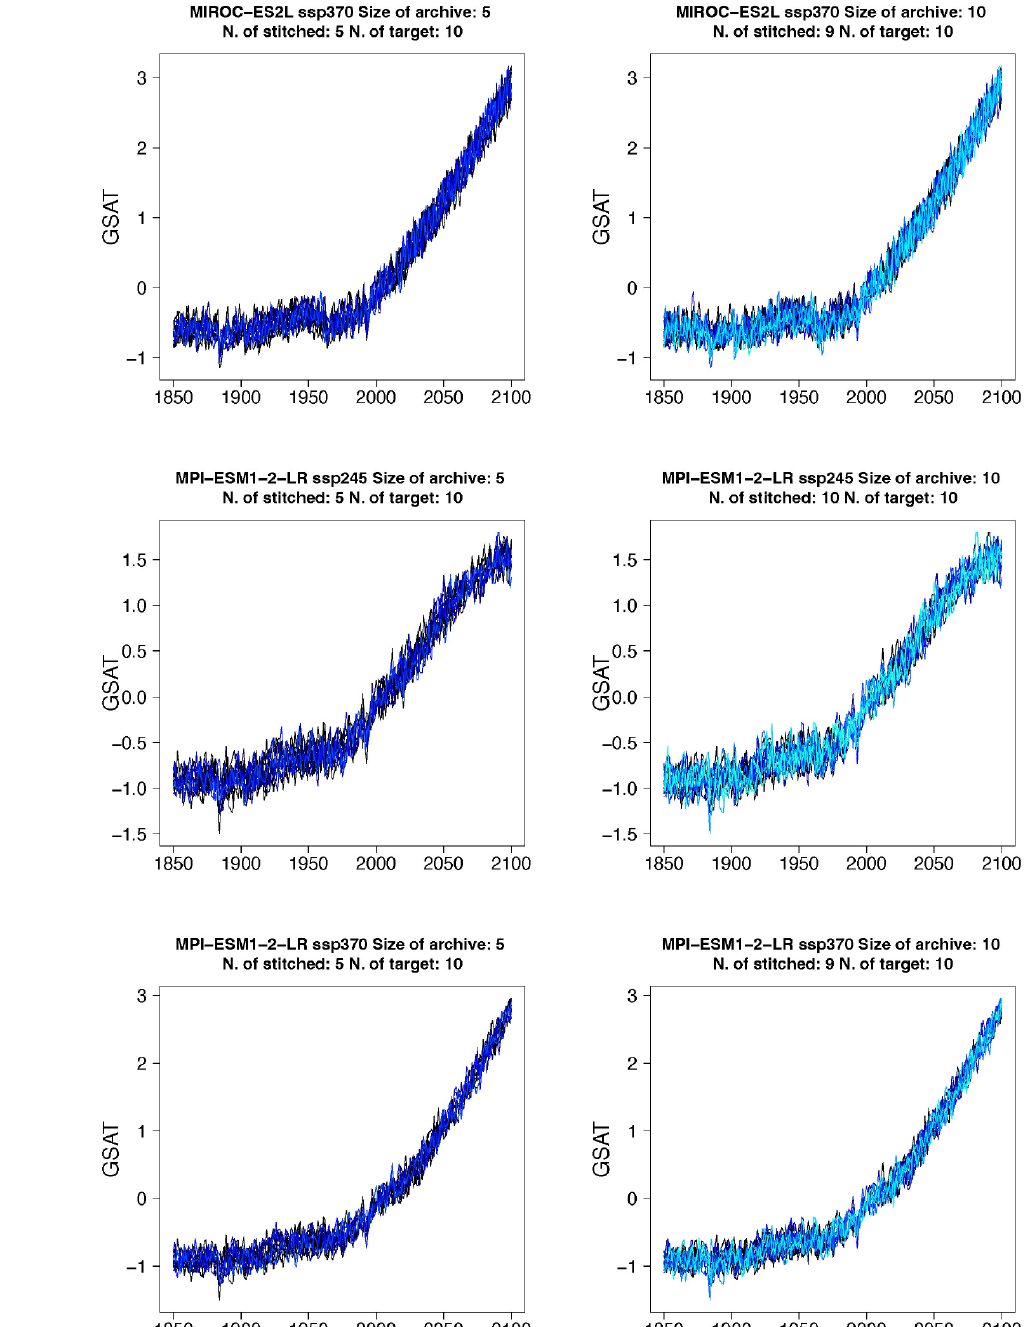
Figure E4. Examples of enriched ensembles of GSAT time series for ESMs in the PANGEO archive that have at least five trajectories available over the 21st century. As in the figures in Appendix A, warmer colors indicate a larger number of stitched trajectories in the figure, as the title also